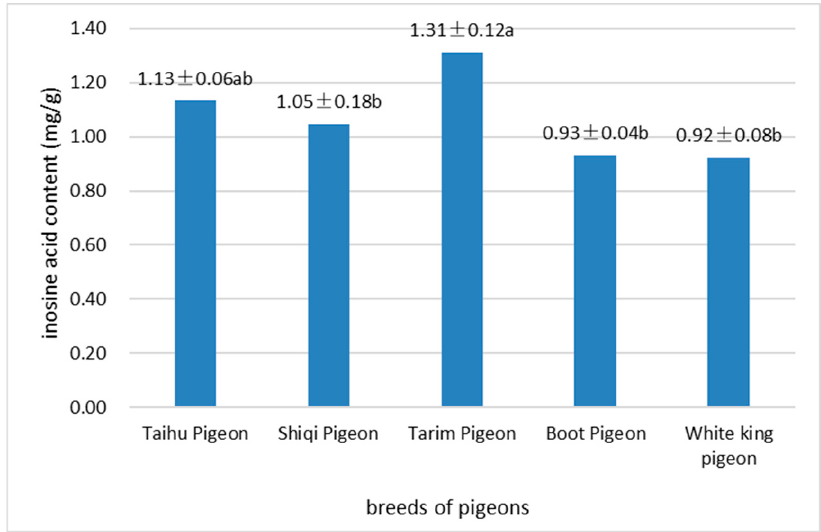
Figure 1. Comparison of the inosine acid content between different breeds of pigeons. Note: Different le tt ers indicate signi fi cant di ff erences ( p < 0.05).